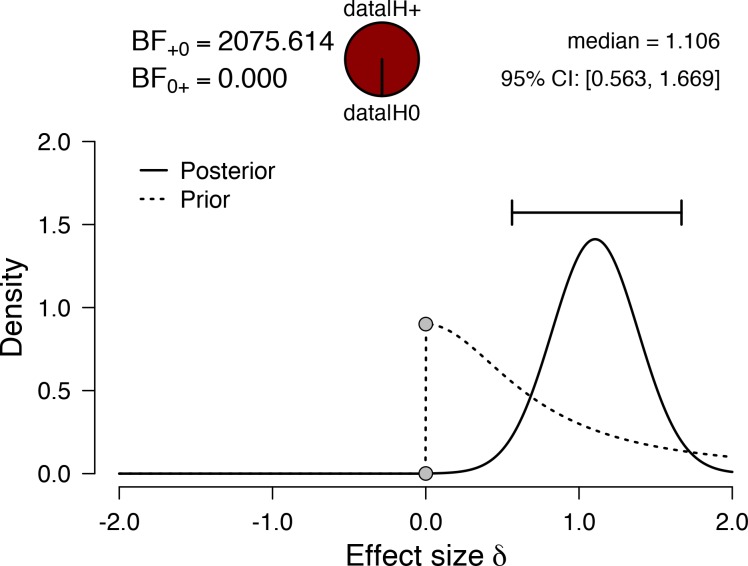
Prior and posterior effect size distributions, together with the effect size point estimate and associated 95% credible interval arising from a paired-sample Bayesian t-test examining the mean difference between %HRR-CV and %HRR-AR.The Bayes10 factor provides strong evidence for the alternative hypothesis that %HRR-AR is lower than %HRR-CV. The effect size of 1.1 suggests a large difference between the two means. BF = Bayes factor.